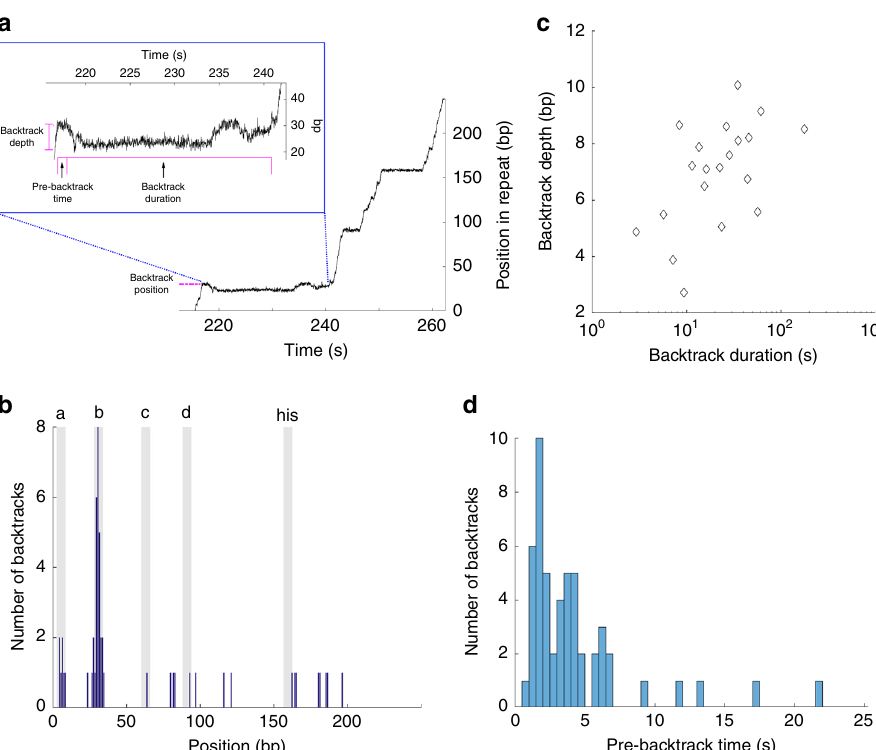
Fig. 3 Backtracking dynamics. a Analysis of backtracking events. The trace shown contains a backtracking event occurring at site ‘ b ’ . The backtrack depth, pre-backtrack time and backtrack duration are shown. b Histogram of backtracking events by position (blue). Gray zones in the fi gure indicate the ± 3 bp region surrounding each major pause site. c Backtracking depths and times measured at opposing forces for site ‘ b ’ . d Histogram of pre-backtrack times measured at site ‘ b ’ at opposing